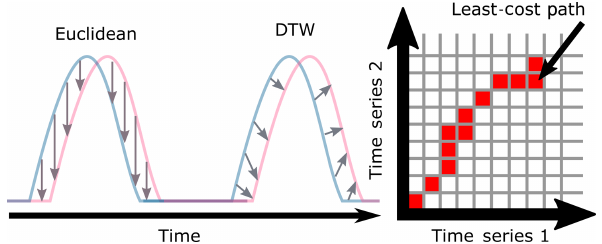
Figure 5. Euclidean distance vs. DTW distance between two time